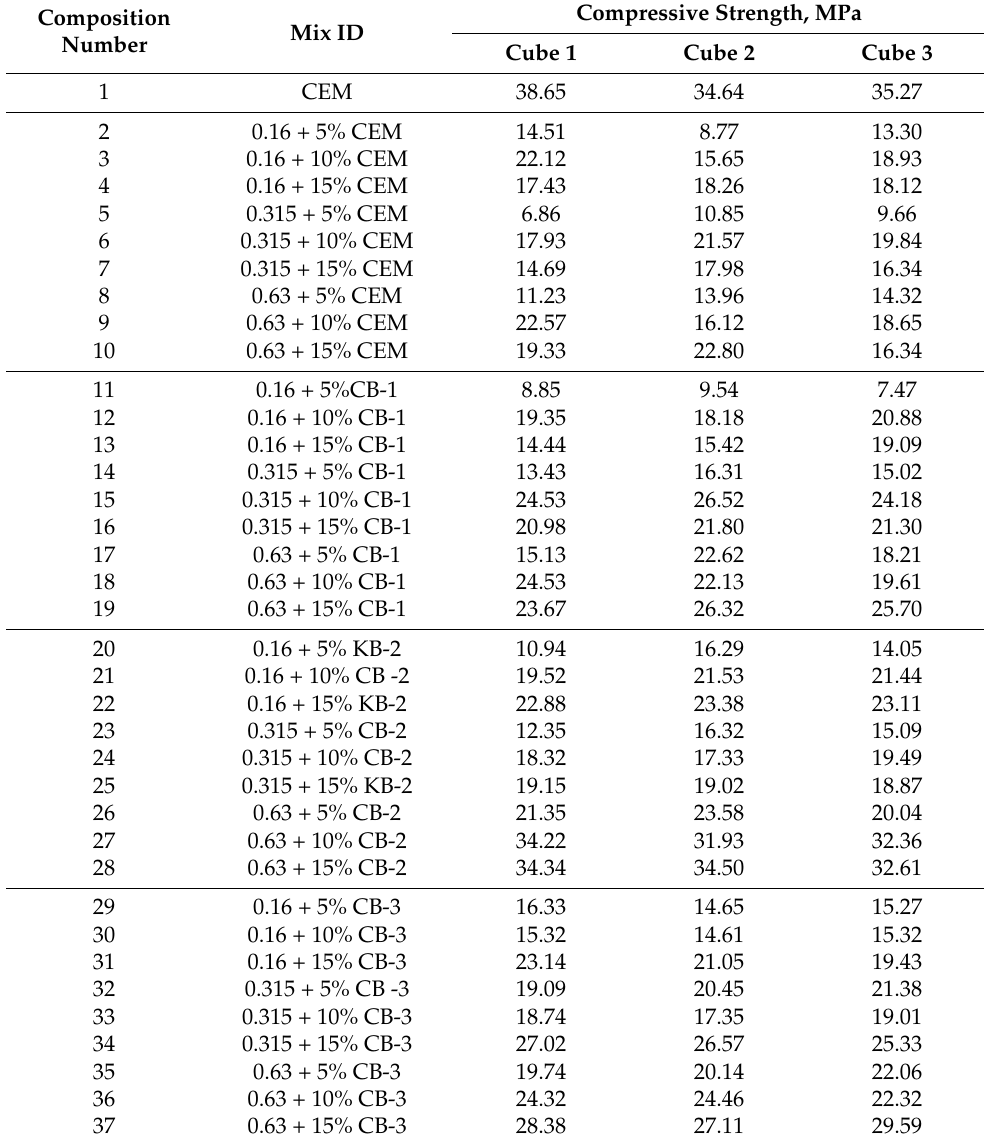
Table 5. Results of compressive strength tests for sample cubes made of Portland cement and